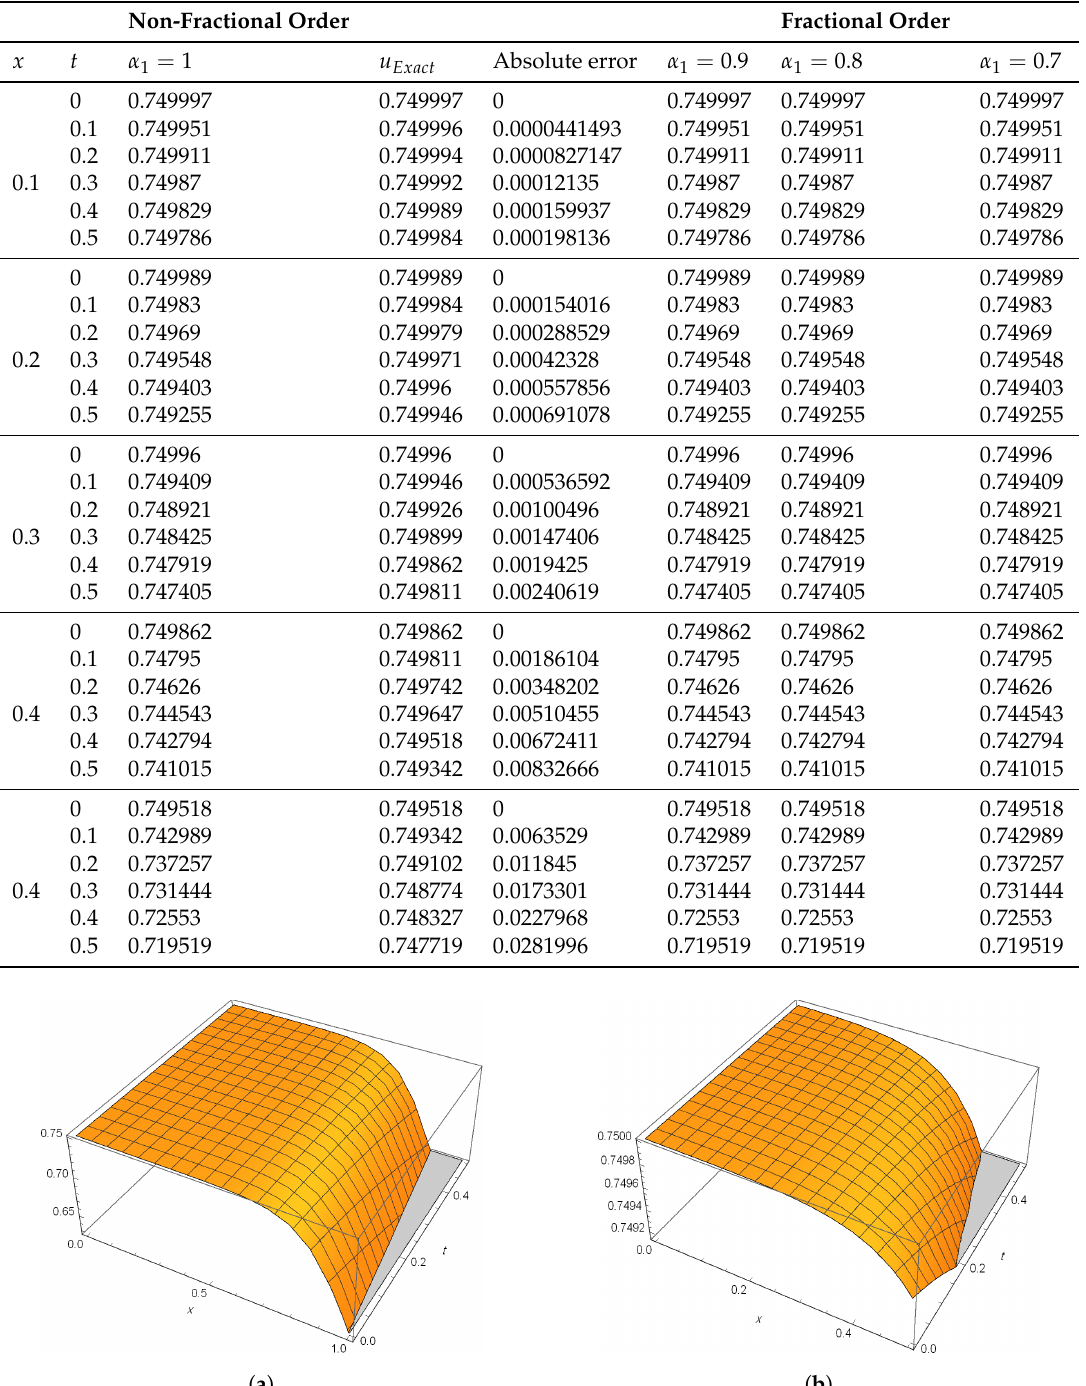
Table 4. Fourth order approximate numerical solutions of u 4 ( x , y , t ) by FRDTM at different values of α 1 and comparison of absolute errors at α 1 = 1, y = 1 and R = 100.